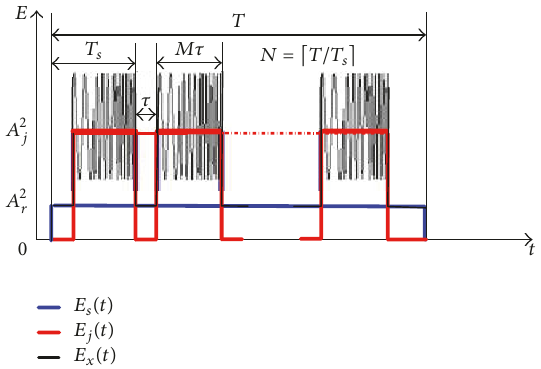
Figure 3: Energy